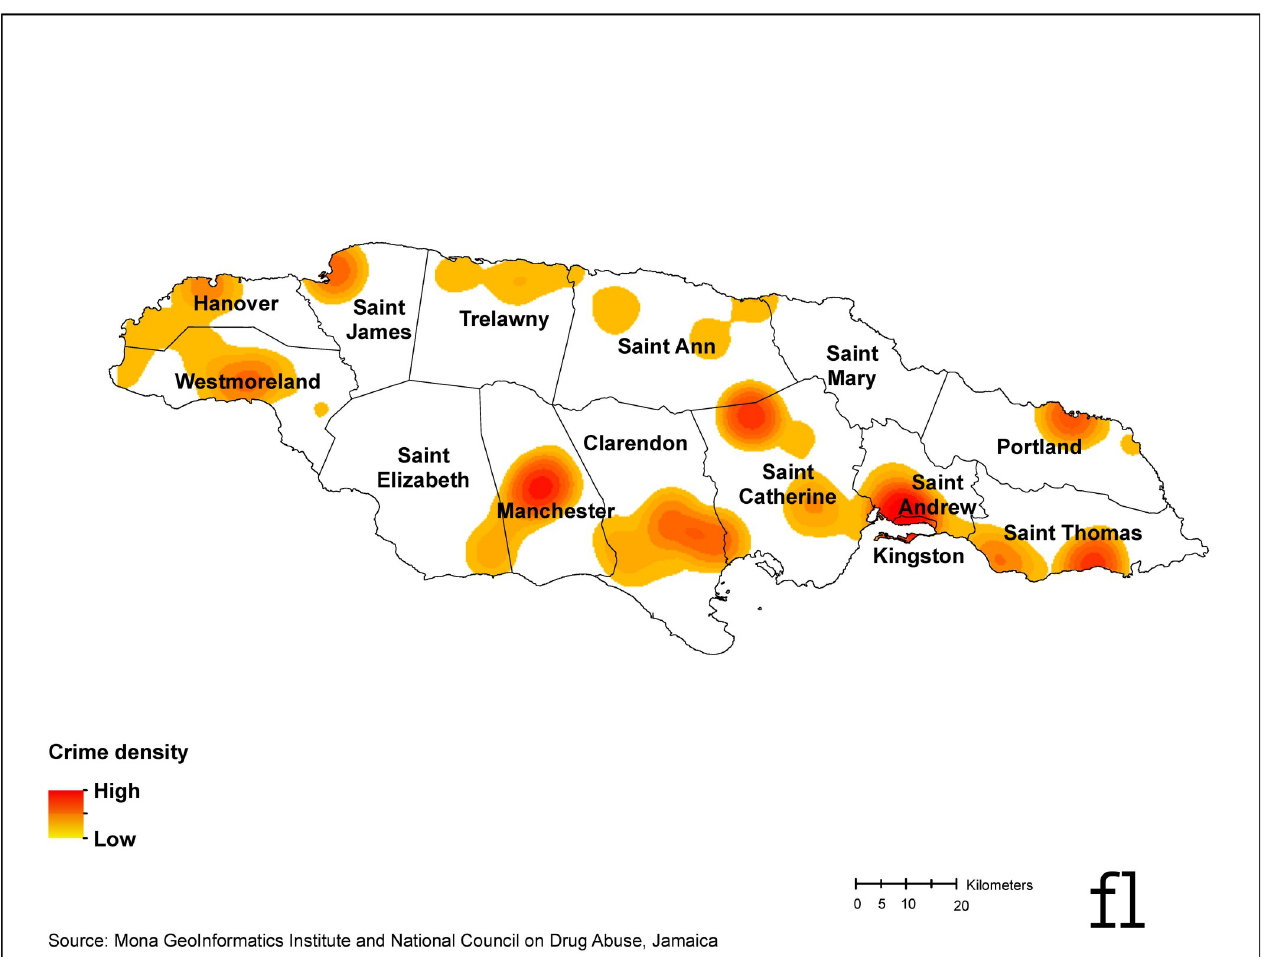
Fig 1. Crime density map, Jamaica 2015–2016. Geographic data source: Mona GIS, Jamaica. Published under a CC BY license, with permission from Mona GeoInformatics Institute, original copyright 2019.